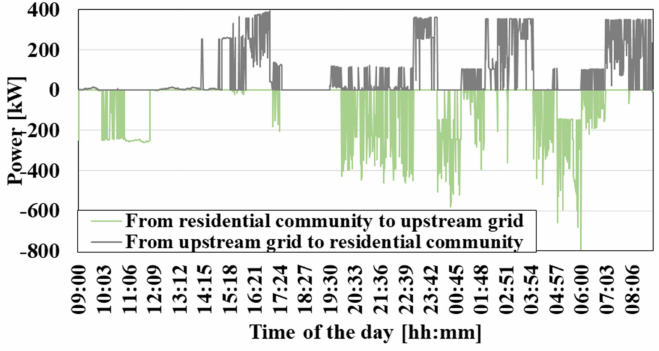
Figure 16. Power exchange data of the residential community with the upstream